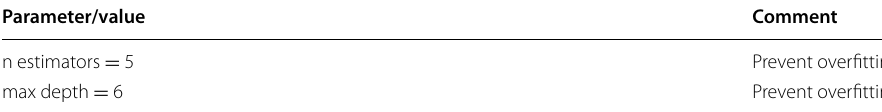
Table 4 Random Forest classifier hyper-parameters